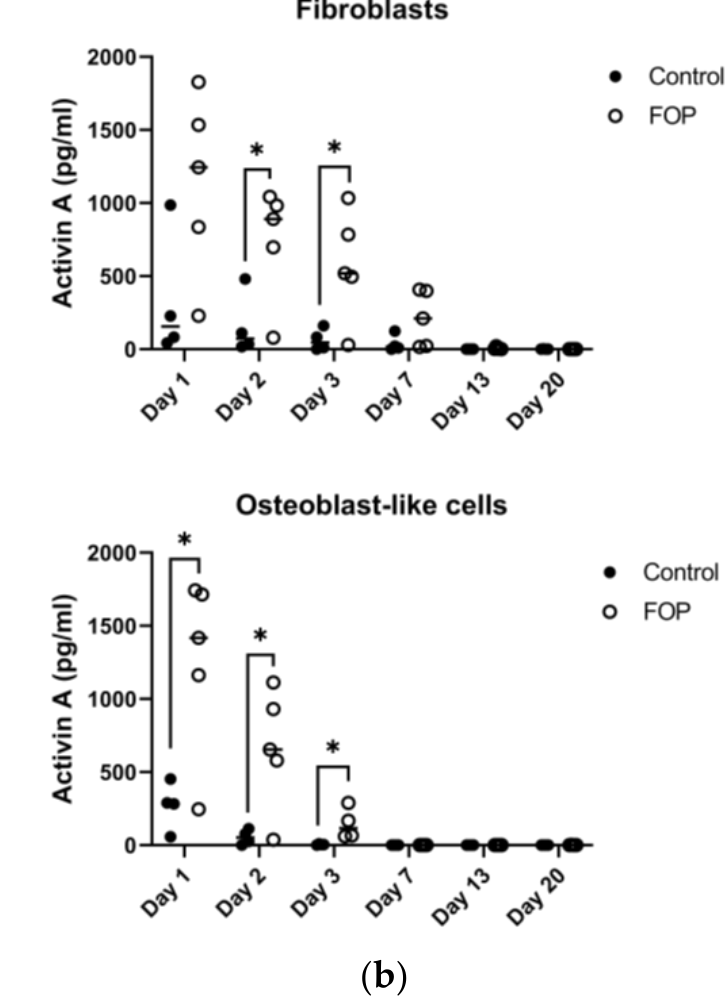
Figure 2. Production of Activin A as measured by ELISA in control and FOP fibroblasts. ( a ) After 24 h of seeding, Activin A was measured in the cell supernatant. ( b ) Activin A was measured on day 1, 2, 3, 7, 13, and 20 in fibroblasts and in osteoblast-like cells during osteogenic transdifferenti- ation. Data indicates Activin A production per cell line and their mean. * p < 0.05 and ** p < 0.005 as determined by standard student’s t -test.